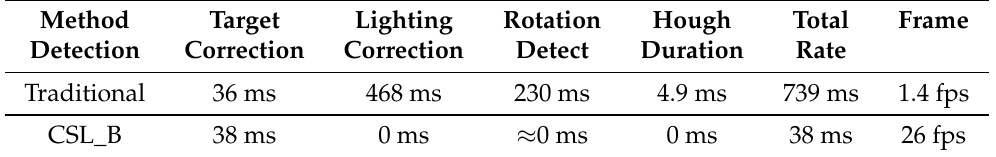
Table 6. Relative angle